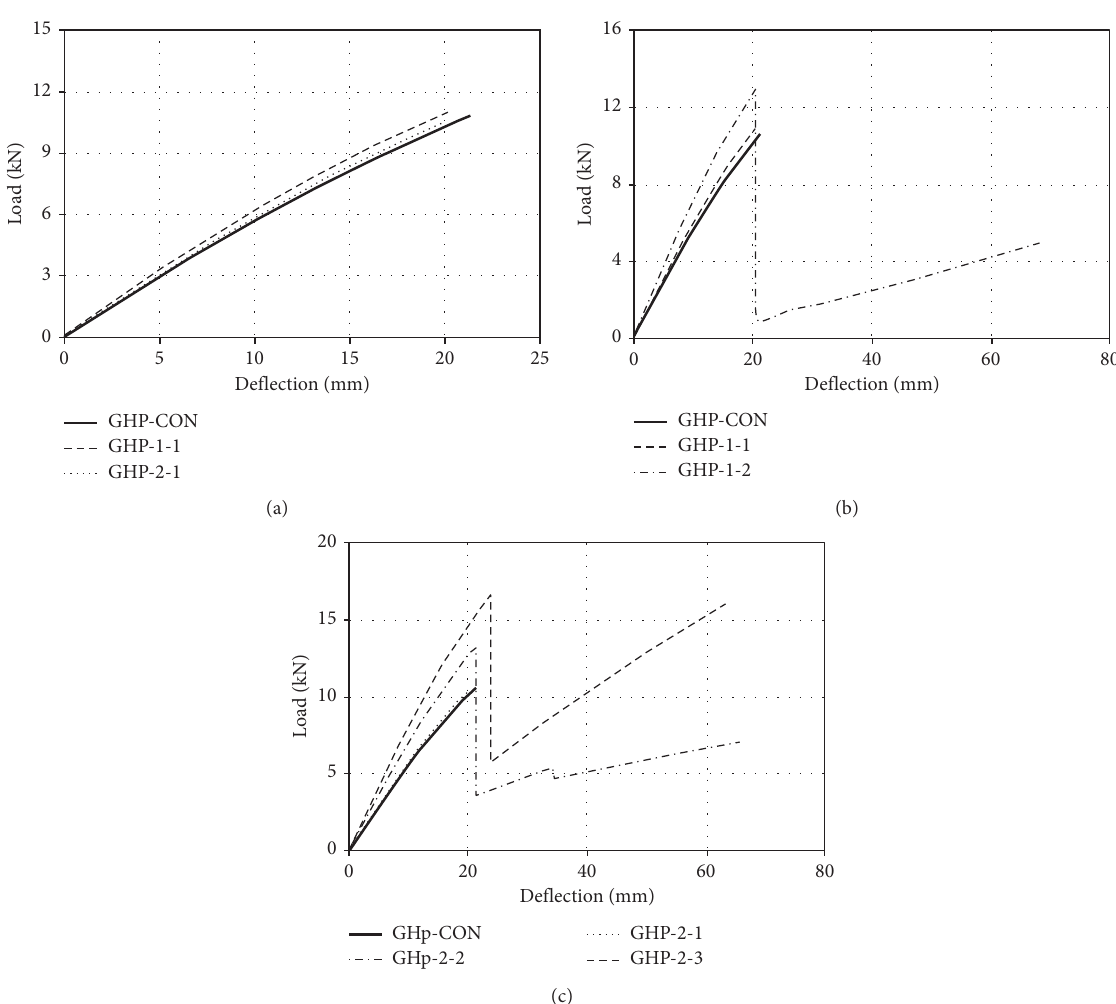
Figure 4: Midspan load-deflection response of GHP specimens. (a) Specimens with different layers of ribs. (b) Specimens with different densities of the PU foam core. (c) Specimens with functional PU foam